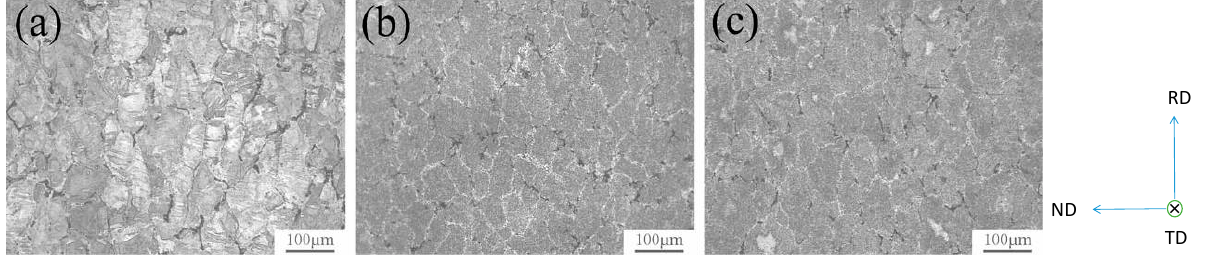
Figure 2. Microstructure of rolled alloys with different compositions: ( a ) 0 Ag (7075), ( b ) 0.2 Ag and ( c ) 0.4 Ag .Adapted with permission from ref. [34]. 2015 Xu.